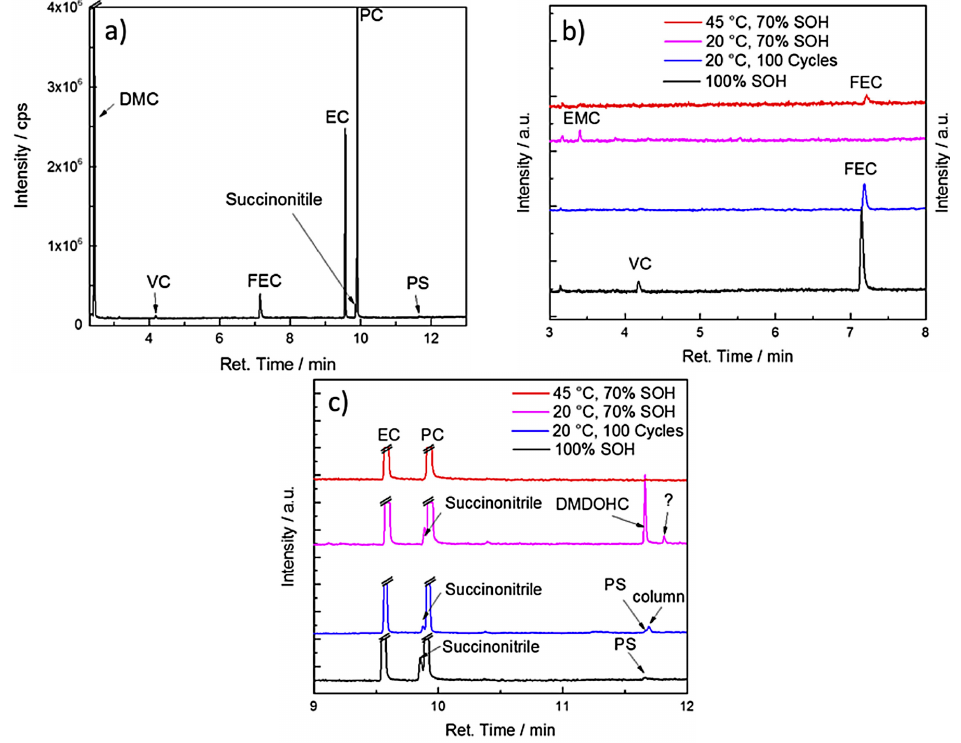
Figure 13. GC-MS investigations on the electrolyte of a fresh cell extracted with supercritical CO 2 ( a ); and comparisons of fresh and aged electrolytes at significant retention times ( b , c ). It was reproduced from reference [165] with permission from Elsevier, 2017.